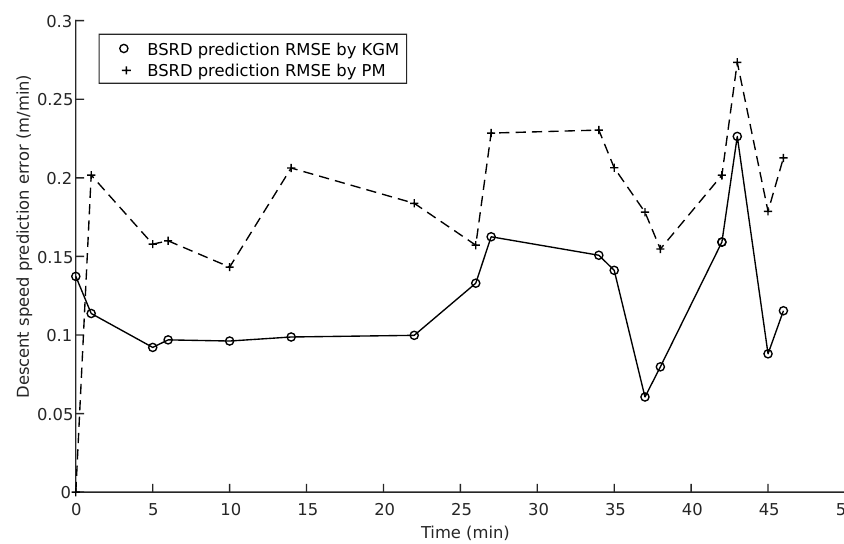
Figure 11. Model comparison of the variation in prediction performance with